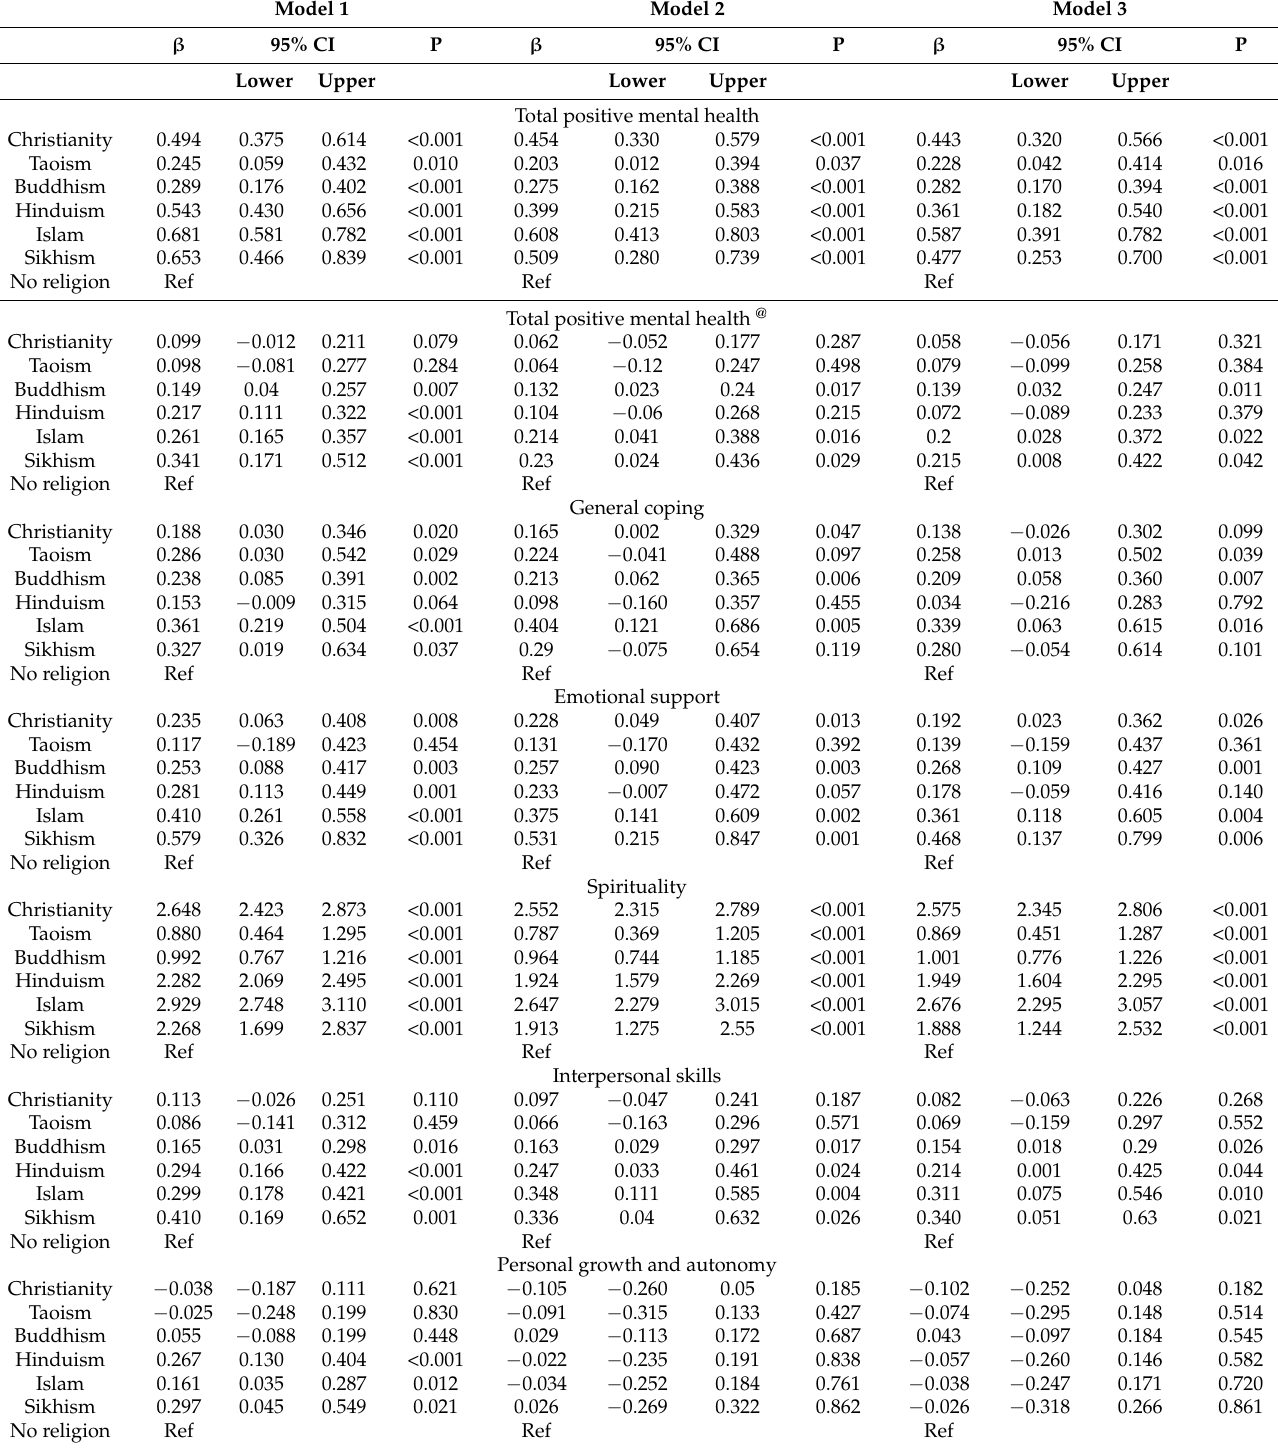
Table 4. Association between specific religious affiliations and positive mental health subcomponents. Model 1 Model 2 Model